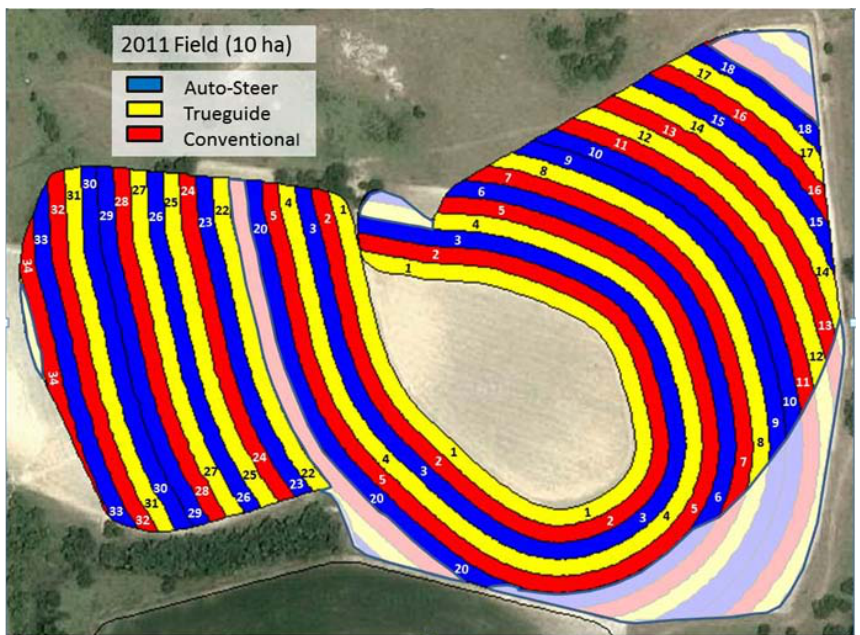
Figure 3. Experimental design used in 2011. Each replicate (colored strip) = 12 rows of peanuts or three 4-row passes. Numbers indicate strips used during data